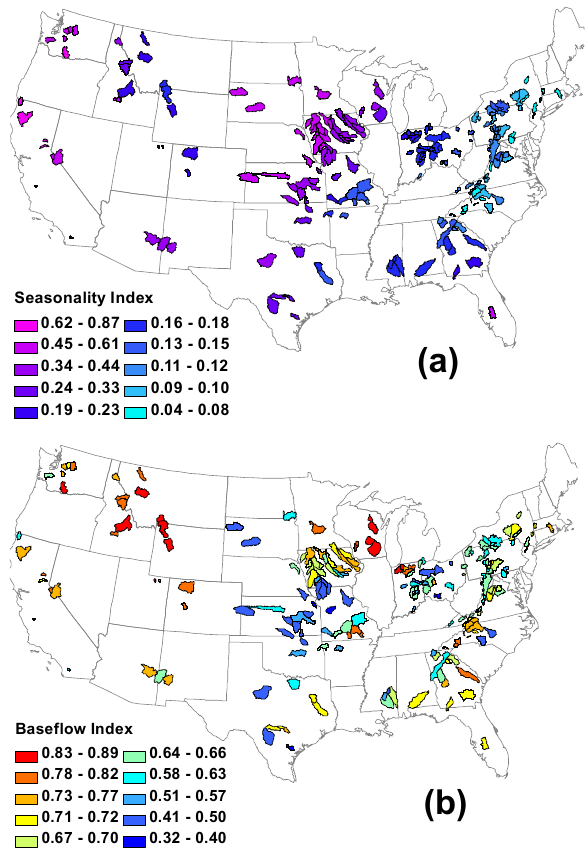
Fig. 1. Spatial patterns of seasonality index (a) and baseflow index (b) across the continental